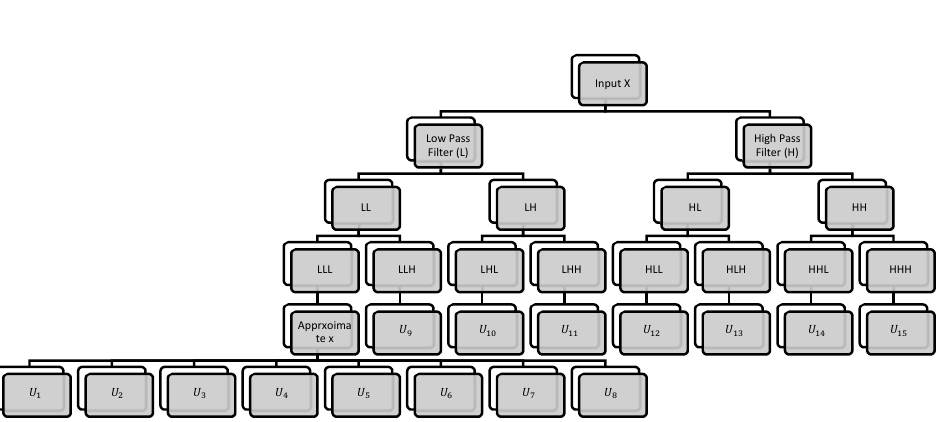
Figure 2. Three-dimensional DWT flowchart.